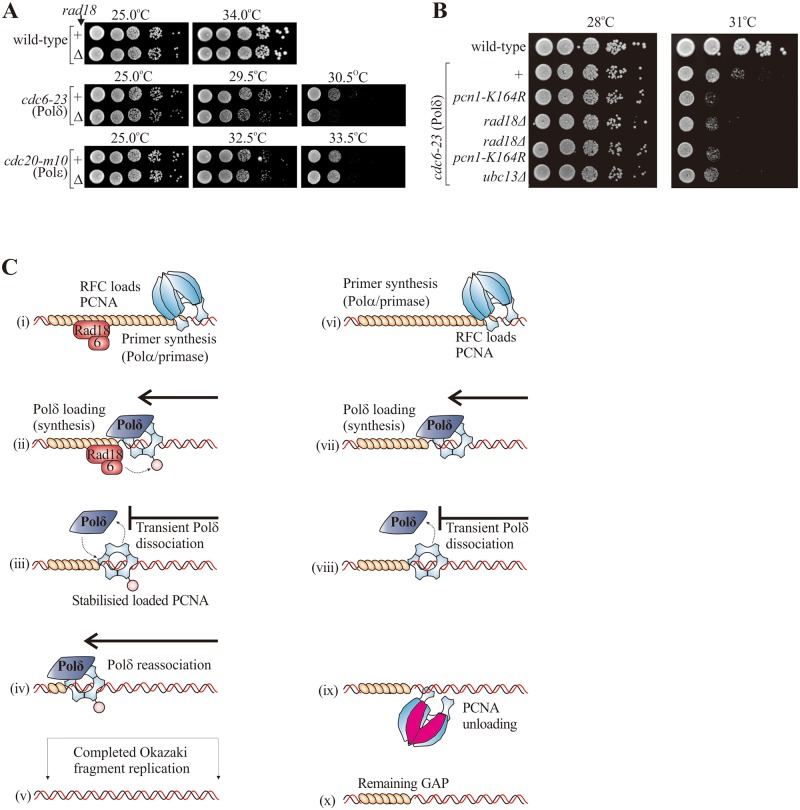
PCNA ubiquitylation predominantly affects Polδ function.(A) Spot tests showing the influence of PCNA ubiquitylation on cell growth/viability in genetic backgrounds compromised for Polε or Polδ function. cdc20-m10 and cdc6-23 are temperature sensitive mutations in the catalytic subunits of Polε and Polδ, respectively. (B) The effect of pcn1-K164R mutation and rad18 deletion on the temperature sensitivity of cdc6-23 (Polδ) are epistatic. (C) Model. Left: Schematic of Okazaki fragment synthesis. (i) Following priming by Polα-primase PCNA is loaded by RFC. (ii) Polδ associates with PCNA and synthesis begins. Rad18-Rad6 mono-ubiquitylates PCNA. (iii) Stochastic dissociation of Polδ from PCNA. Ubiquitylation prevents PCNA dissociation/unloading. (iv) Polδ re-associates with PCNA and synthesis resumes. (v) Okazaki fragment synthesis is completed. Right, a potential effect of loss of Rad18: (vi) Following priming by Polα-primaae PCNA is loaded by RFC. (vii) Polδ associates with PCNA and synthesis begins. (viii) Stochastic dissociation of Polδ from PCNA. (ix) PCNA is not ubiquitylated and thus can dissociate (possibly unloaded by Elg1). (x) Okazaki fragment synthesis is not completed and a gap remains.